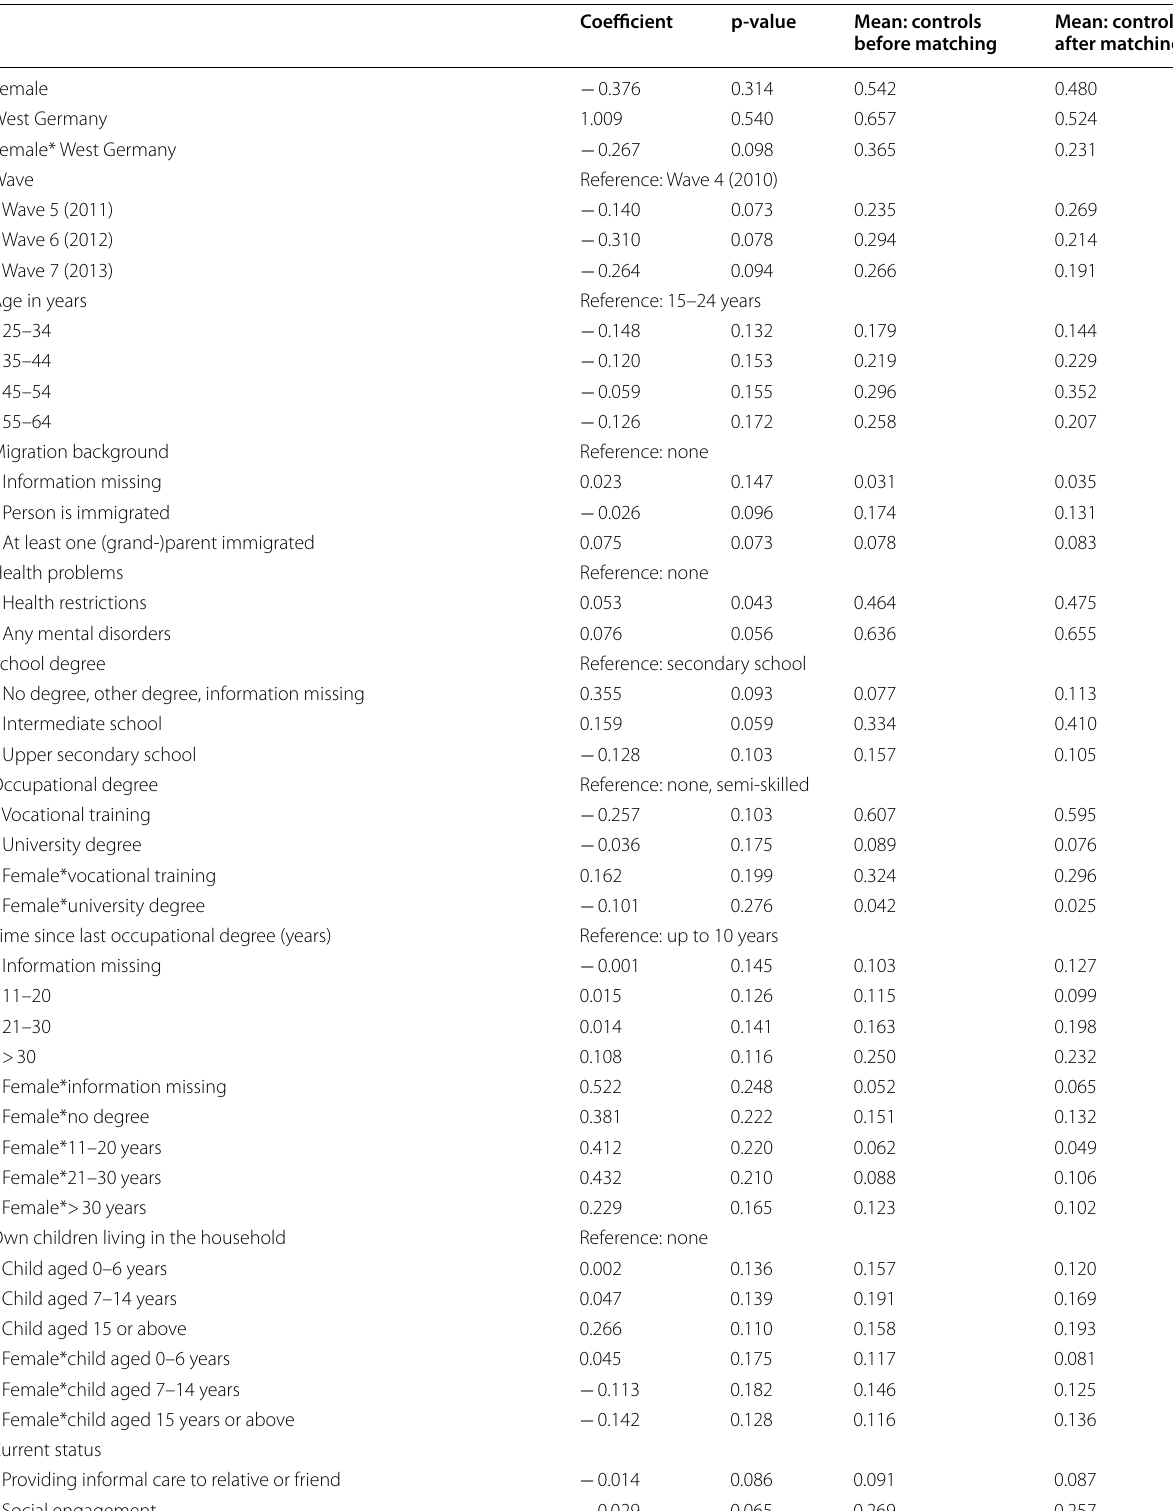
Table 7 Coefficients of probit estimates and shares among controls before and after matching. Source: